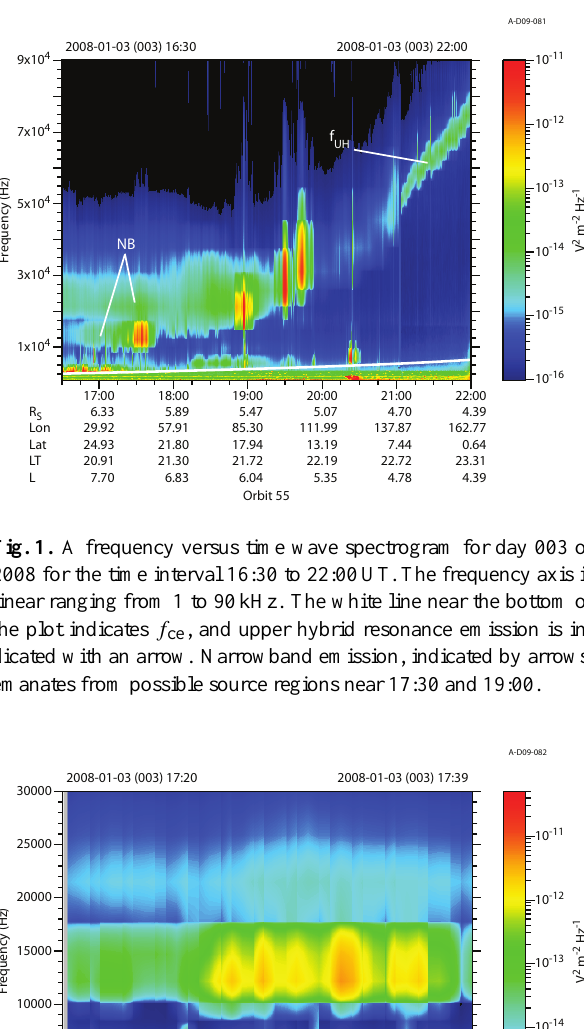
15 kHz has a red color (+1) corresponding to left-hand cir- cular (LHC) polarization for times greater than about 17.5 h, but is mixed for earlier times. The polarization of O-mode emission is left-hand circular (LHC), and for f p / f ce > 1, the polarization of Z-mode is also LHC. The LHC polarization of Z-mode and O-mode thus appear red (+1) on the spectro- gram. We interpret the transition from light blue ( V ≈ − . 25) to red at ∼ 15 kHz near 17.5 h to indicate that the Cassini spacecraft travels through the source region thus experienc- ing wave vectors, k , that reverse direction relative to the local magnetic field producing a reversal of the polarization. The reversal of polarization can be interpreted as evidence that the spacecraft traverses the source region. This interpreta- tion assumes the emission wave mode does not change and is always observed from the same side of the antenna plane (the plane containing the Cassini U and V antennas, which lie in the spacecraft x-y axis). Thus the satellite is believed to have passed very near the source region. In the bottom panel of Fig. 3 we show the azimuth angle of the direction to the source with respect to spacecraft coor- dinates. The color bar is in units of radians. The spacecraft orientation relative to Saturn equatorial coordinates changes very little during the time interval of Fig. 3. The importance of this panel is that it shows a rapid change of direction to the source region near 15 kHz and 17.5 h, supporting our inter- pretation of a spacecraft traversal of the NB source